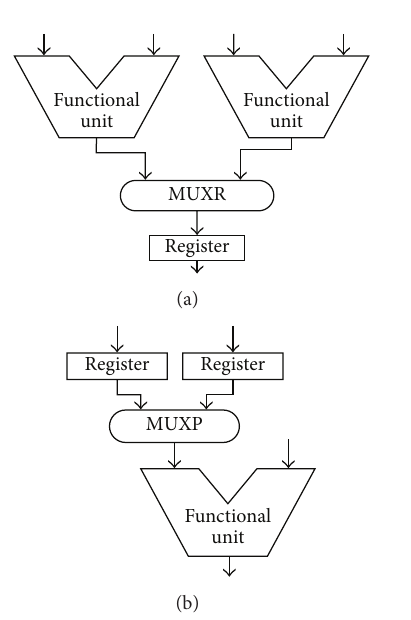
Figure 6: (a) Multiplexer introduced before a register (b) Multi- plexer introduced before a functional unit